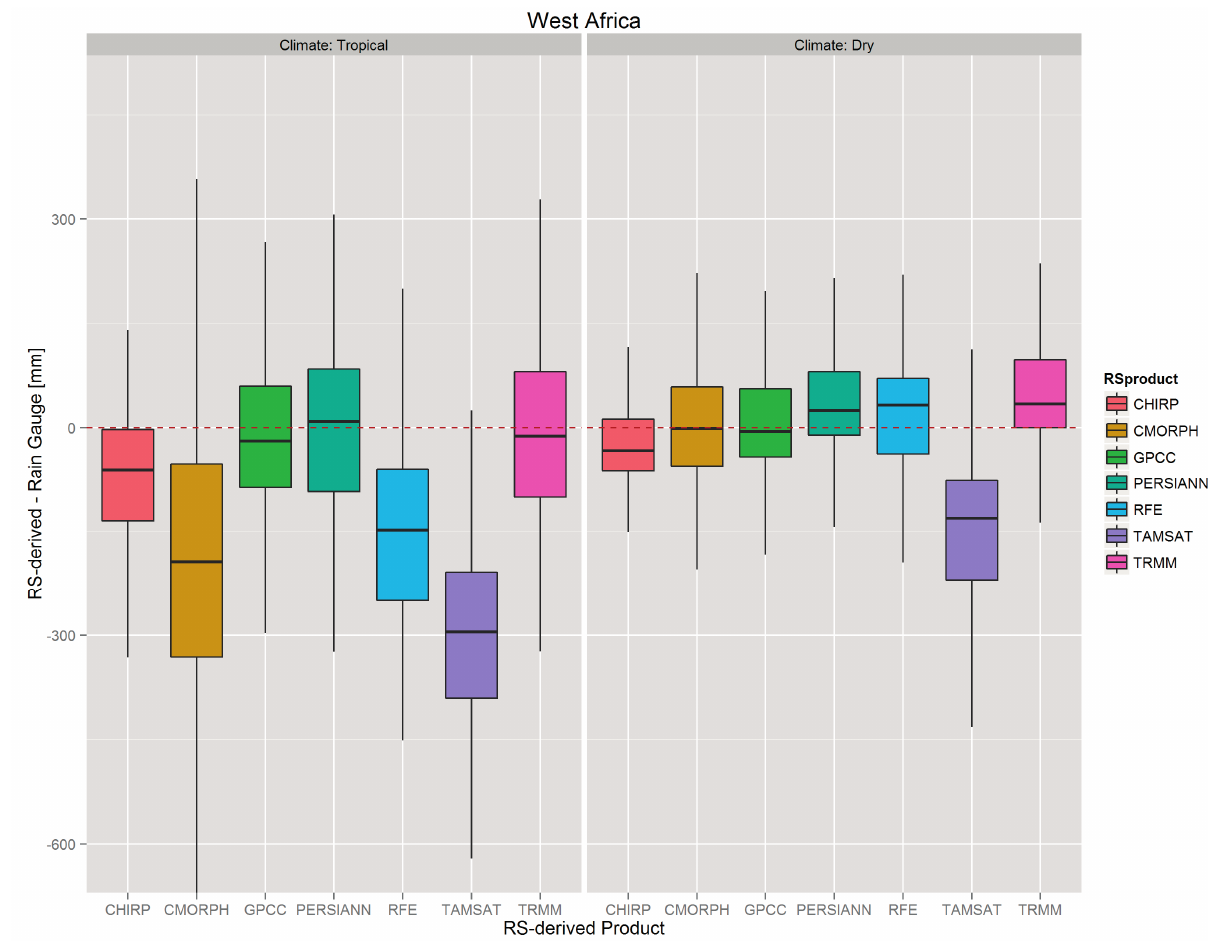
Figure 16. Box-and-Whiskerplot of the difference between downscaled and observed precipitation across West Africa for different climate